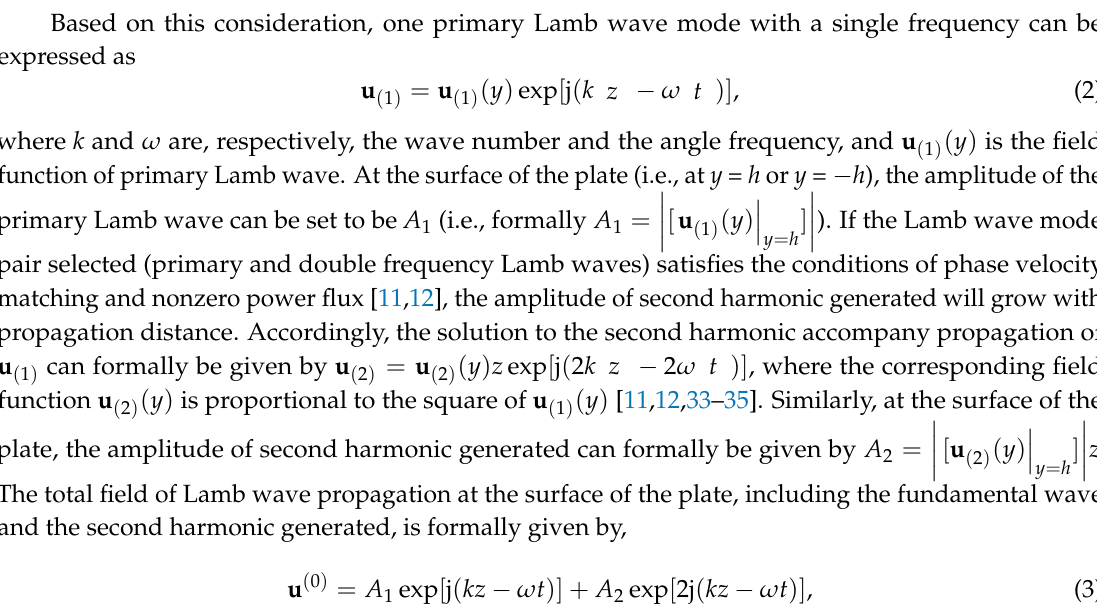
Figure 1. Configuration of a single elastic plate.